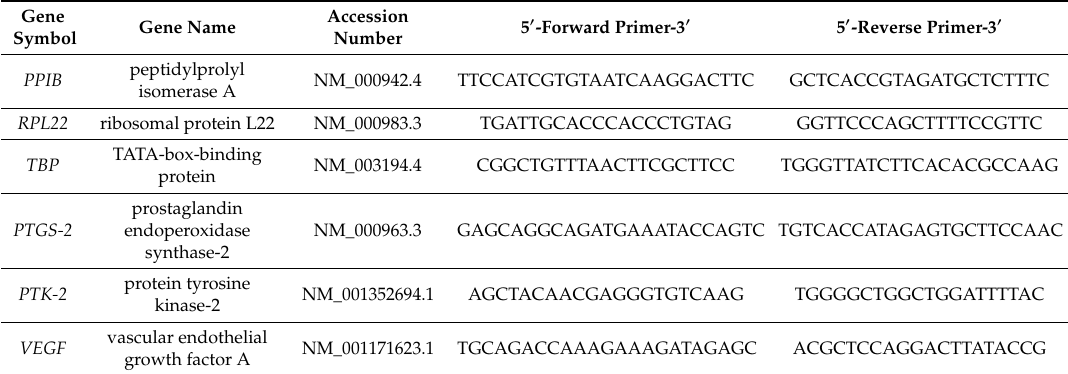
Table 1. Reference ( RPL22 / PPIB / TBP ) and target gene primers used for